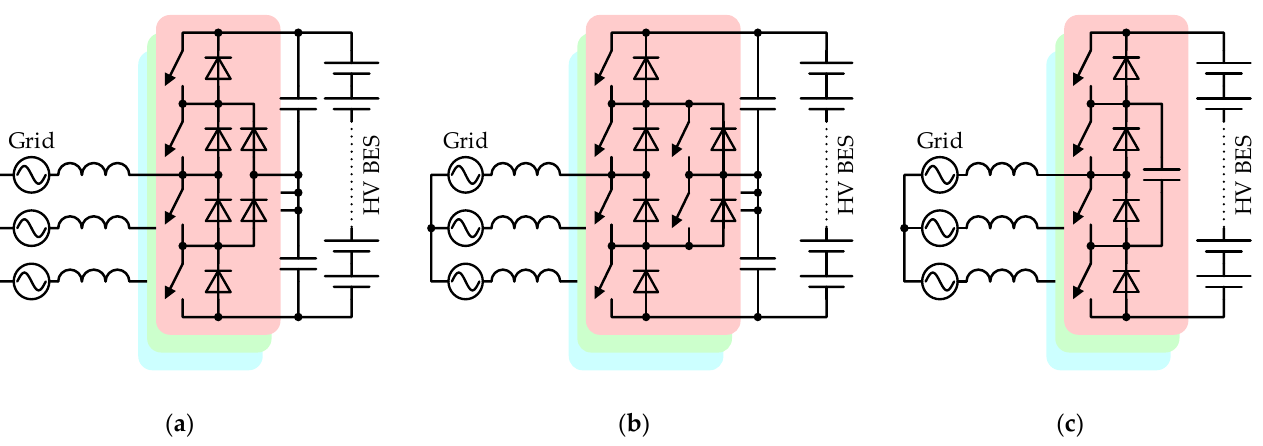
Figure 15. Multilevel converters with solid HV battery: ( a ) diode clamped, ( b ) active clamped, ( c ) flying capacitor.